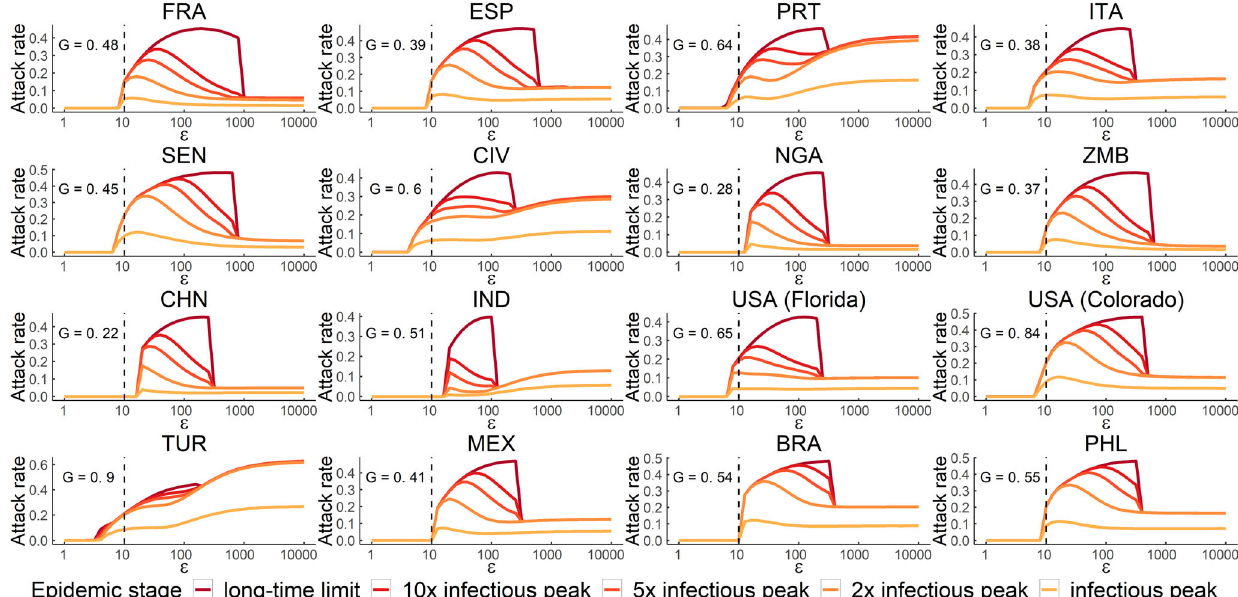
Fig. 5 Criticality in empirical networks characterized by measured human fl ows and population distribution. The panels show the dependence of the attack rate on the scale parameter ϵ for different metapopulation networks, each one identi fi ed with the ISO 3166-1 alpha-3 code of the country it describes. Different colors encode distinct stages of the epidemic as shown in the legend. With epidemic stages we simply mean the stages of development of the epidemic measured using as time unit the time necessary for an epidemic to reach the maximum number of infected (or infectious peak). In all cases, the critical point ϵ ⋆ is clearly visible, since it corresponds to the value of ϵ such that the attack rate is larger than zero. It is worth noticing that such a critical (cid:2) μ Þ represented with a vertical dashed black line (with β ¼ 0 : 2 point is approximately always lower than our analytically found upper bound 1 = ð β max max and μ = 0.1 in this case). The G in each sub- fi gure indicates the Gini coef fi cient of the strength distribution of the corresponding network and it is used to quantify the heterogeneity of each network. Finally, we notice a drop in the attack rate for large values of ϵ : an effect due to the slowing down of the